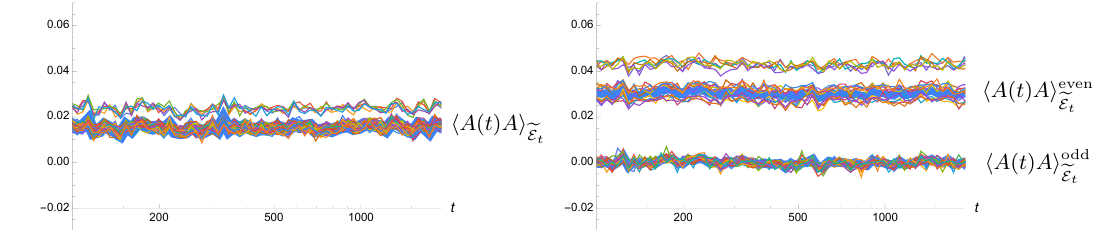
Figure 8 . We plot the 2-point functions of the form h A ( t ) A i for randomly chosen Pauli operators A alongside the spectral form factor R 2 ( t ) for the random 2-local and 3-local Hamiltonians in eqs. (5.2) and (5.1). The form factor, depicted by the thick blue line, exactly equals the average of all 2-point functions, but the variance of the 2-point functions is a lot smaller in the absence of time-reversal symmetry (on the left).